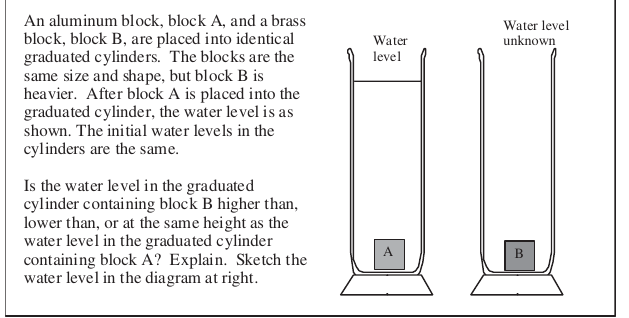
FIG. 2. ‘‘Broken-block’’ density problem posed before instruc- tion on an ungraded quiz in Phys/Chem 102.